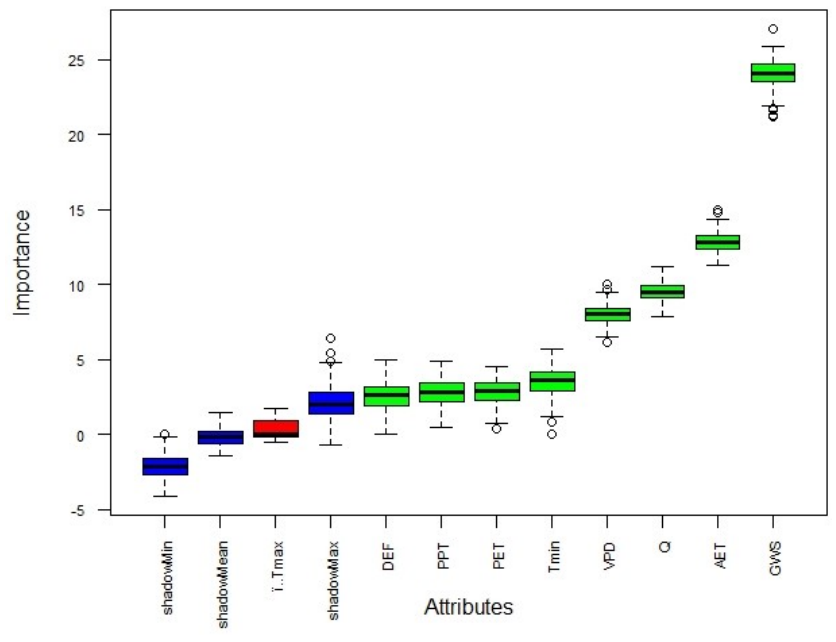
Figure 13. Terrestrial water storage variables importance using Boruta algorithm. Table 3. Considering water storage variables importance using Boruta